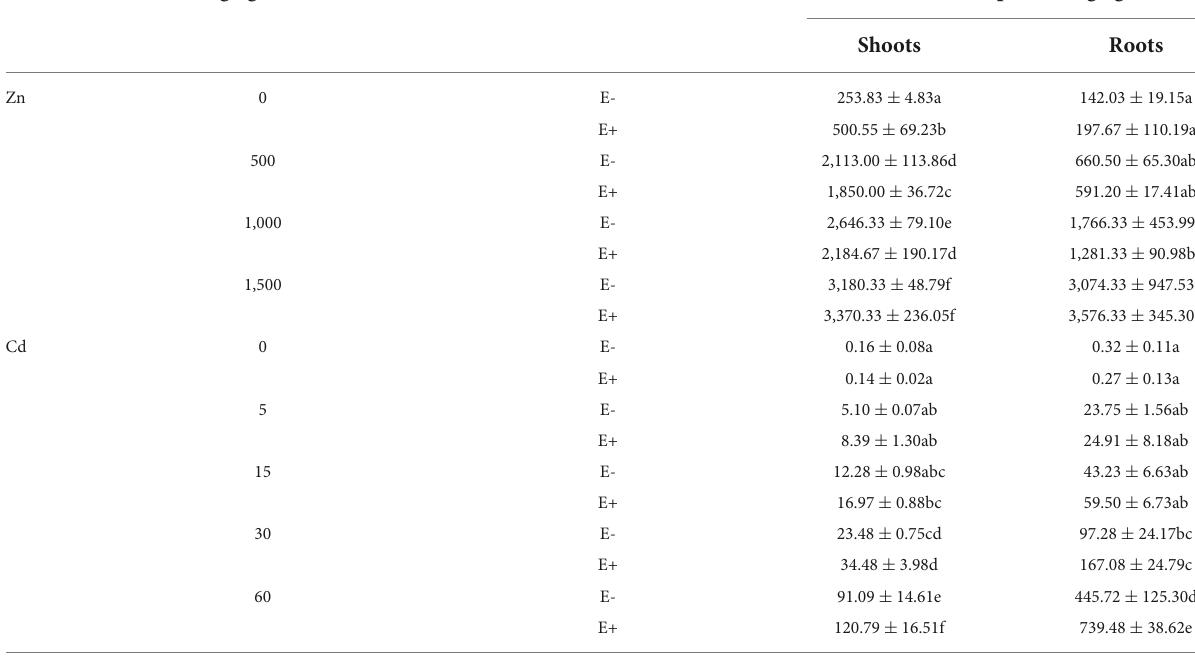
TABLE 1 Zn/Cd accumulation in the shoots and roots of FXZ2 inoculated plants (E+) and non-inoculated plants (E-). The original concentration of Zn/Cd in the soils (mg kg − 1 )